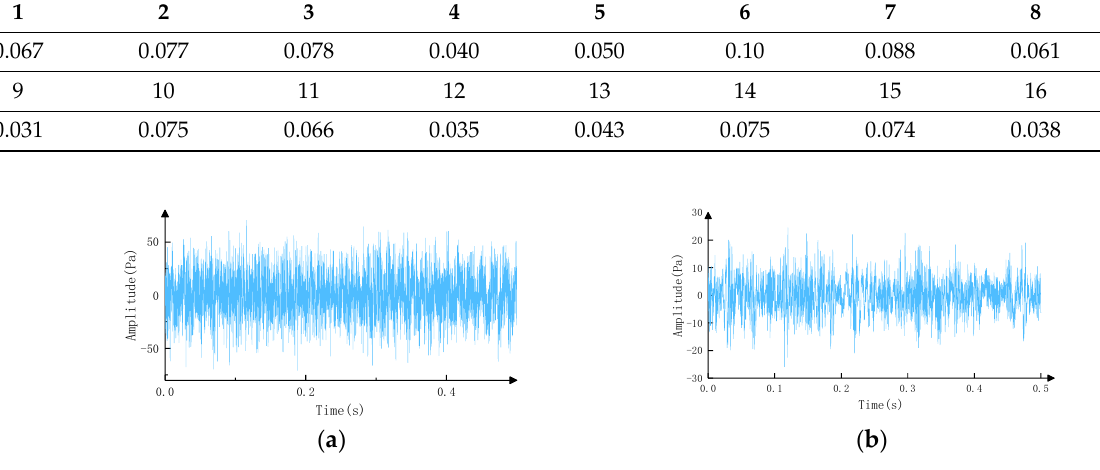
Table 4. Weight of each channel.